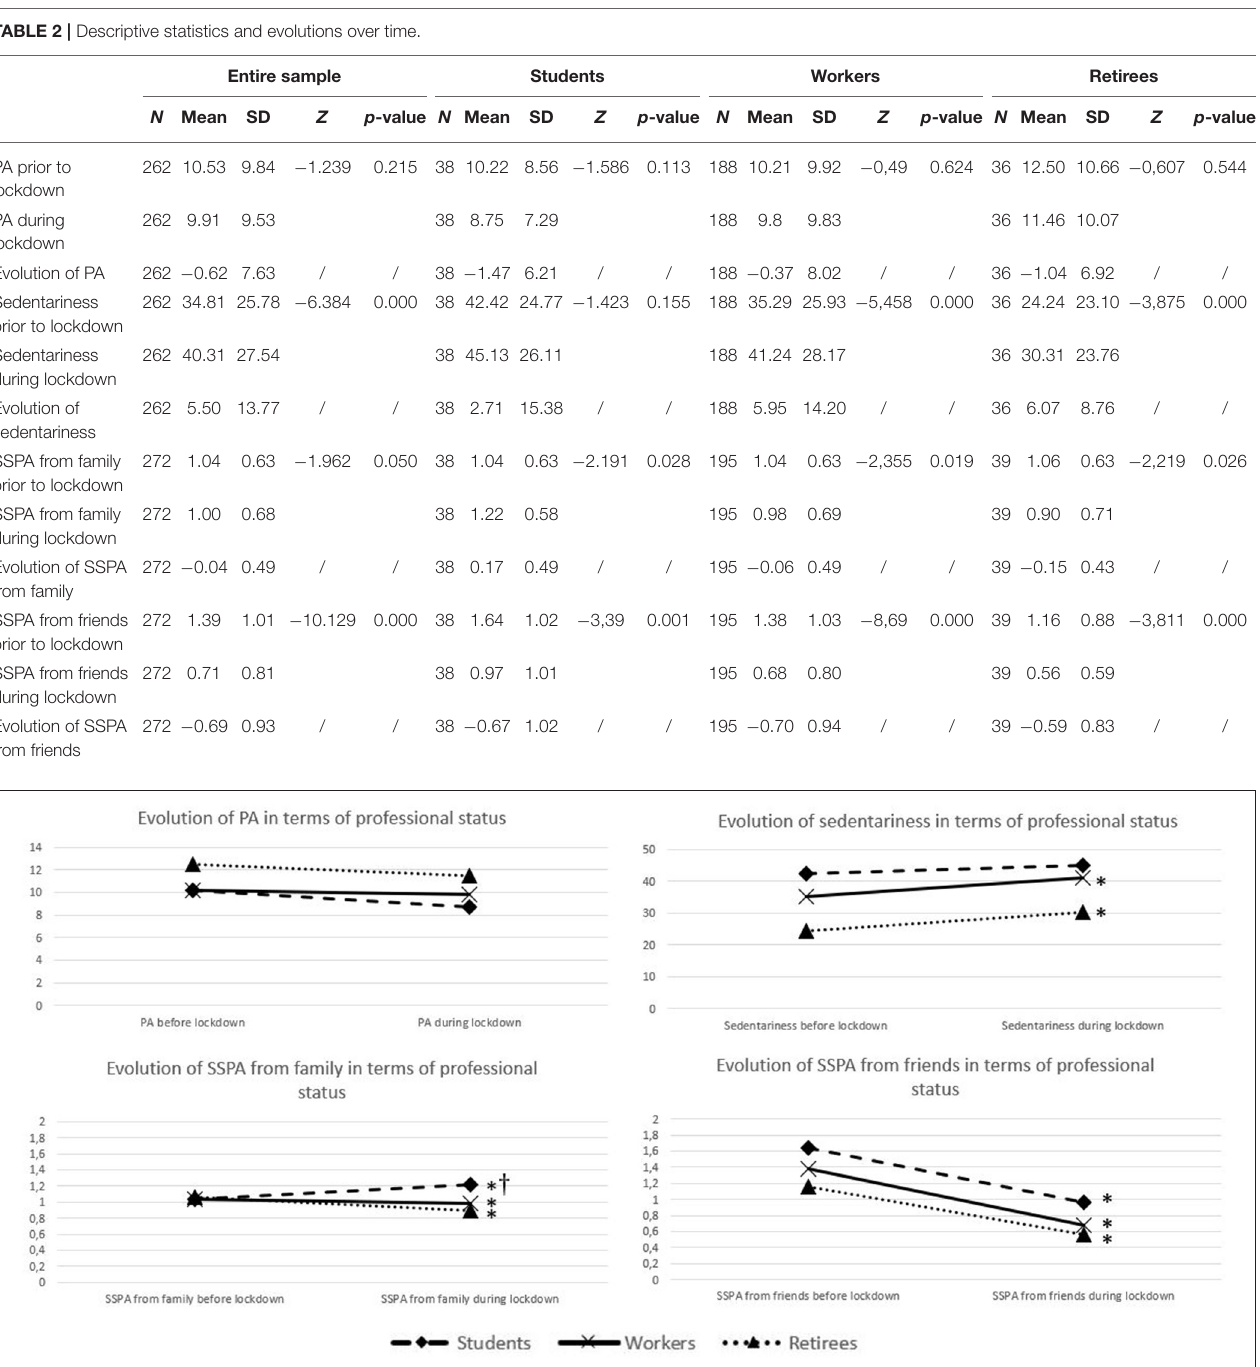
† indicates significant difference between the evolution of students and the evolution of